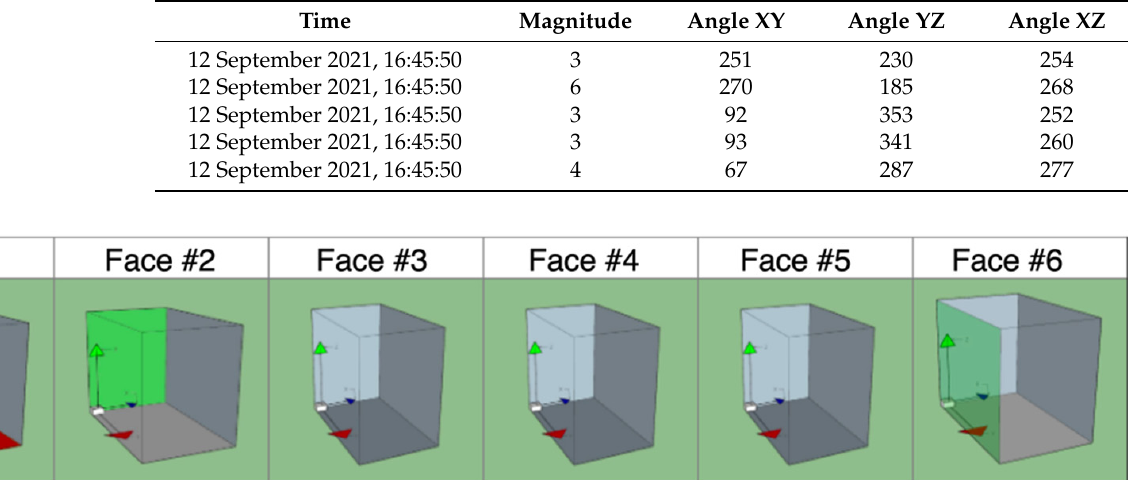
Figure 6. The graphical interface of the shock monitoring web page.